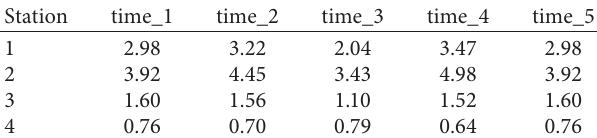
Figure 3: OD data. Table 5: Passenger arrival